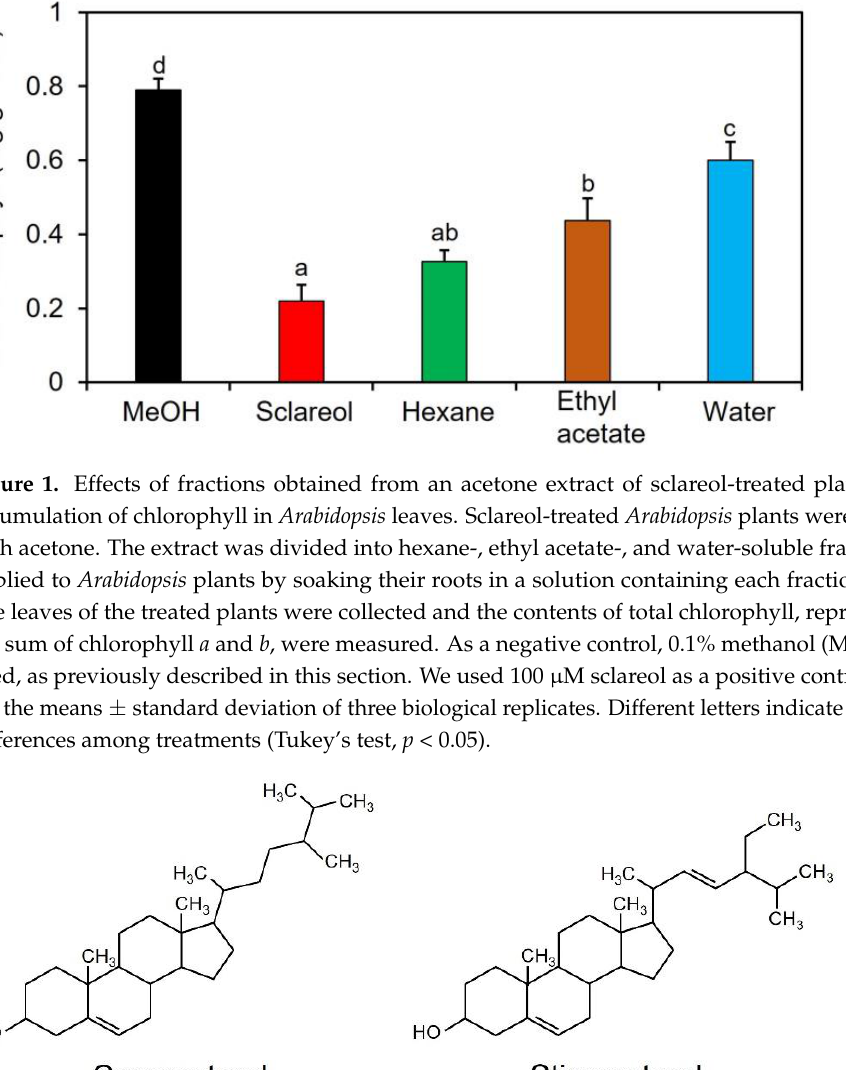
Figure 2. Structures of campesterol and stigmasterol.